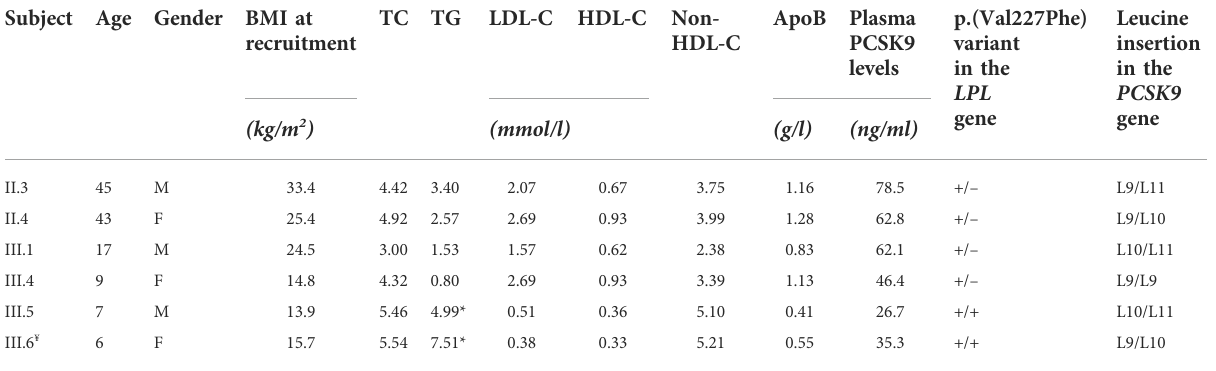
¥ sign indicates the proband. *sign indicates TG value while the patient was under a very strict low-fat diet. The +/+ sign indicates that the individual is homozygous for the p.(Val227Phe) variant in the LPL gene and the +/ – sign indicates that the individual is heterozygous for the variant. The L10 designates the p.Leu21dup or p.L15_L16insL in the PCSK9 gene and the L11 variant designates the p.Leu21tri or p.L15_L16ins2L. Ageatrecruitmentisgiveninyears.BMI,isgiveninkg/m 2 .TC,TG,LDL-C,HDL-C,andnon-HDL-Clevelsaregiveninmmol/l,ApoBlevelsaregivening/landPCSK9levelsaregivenin ng/ml. ApoB, apolipoprotein B; F, female; HDL-C, high-density lipoprotein cholesterol; LDL-C, low-density lipoprotein cholesterol; LPL, lipoprotein lipase; M, male; PCSK9, proprotein convertase subtilisin/kexin type 9; Non-HDL-C, non high-density lipoprotein cholesterol; TC, total cholesterol; TG, triglycerides.